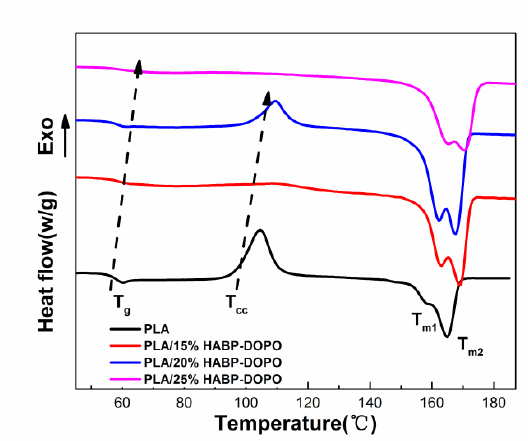
Figure 3. DSC curves of PLA and its blends. Table 3. Detailed results of DSC of PLA and its blends.